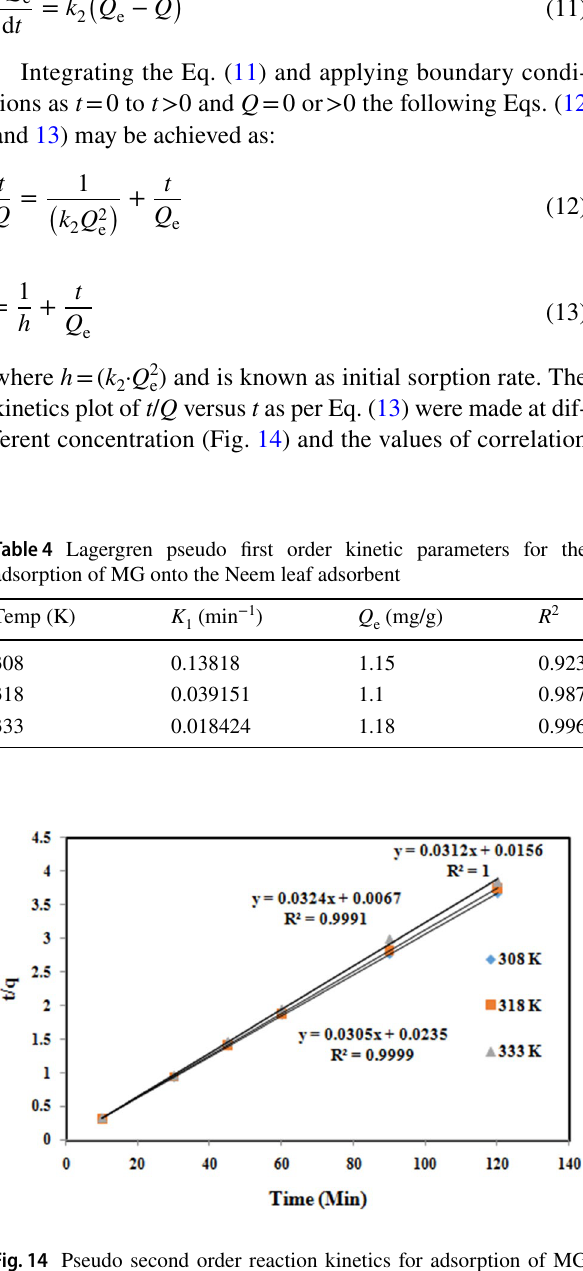
Fig. 13 Lagergren pseudo 1st order reaction kinetics for adsorption of MG (NLP: 3 g/l, MG: 100 mg/l, pH: 4.58)